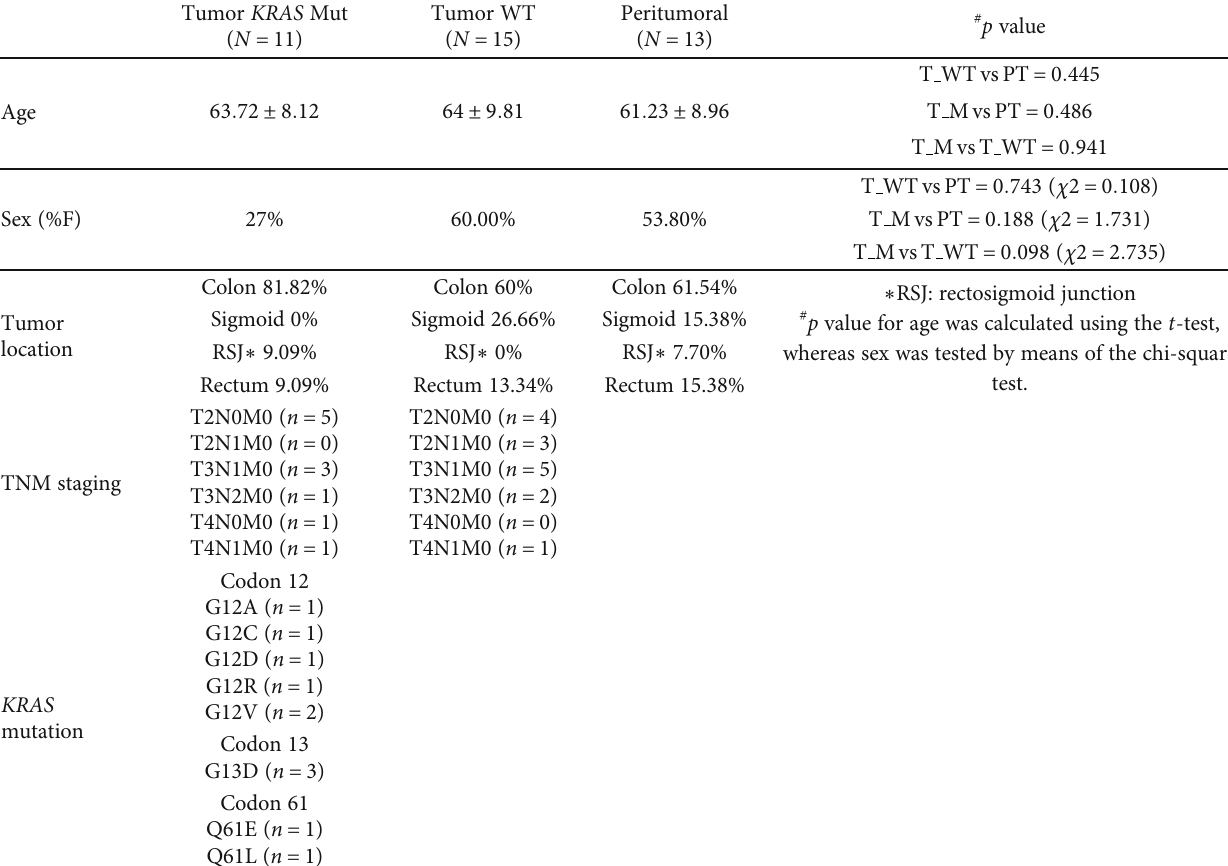
Table 1: Clinical and pathological characteristics of CRC patients involved in the study.